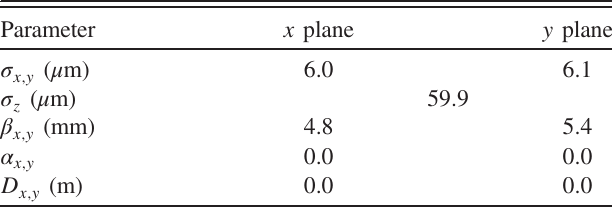
TABLE III. Beam size and linear optics parameters at the injection point for the transfer line shown in Fig.